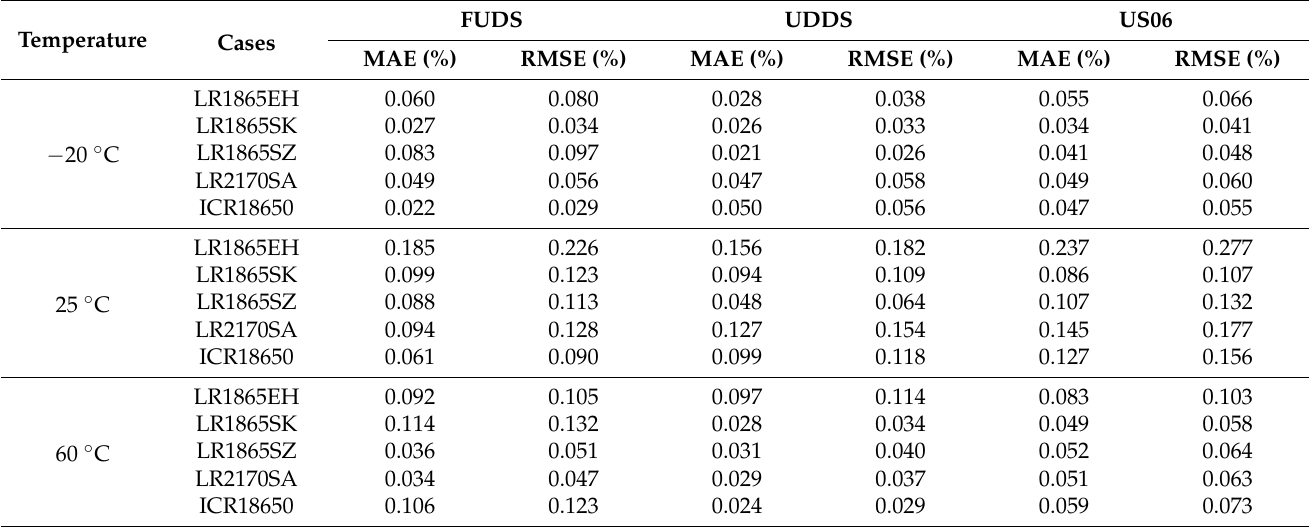
Table 3. SOC estimation performance of the ATCN-v2 model for different types of batteries under different real driving cycles and